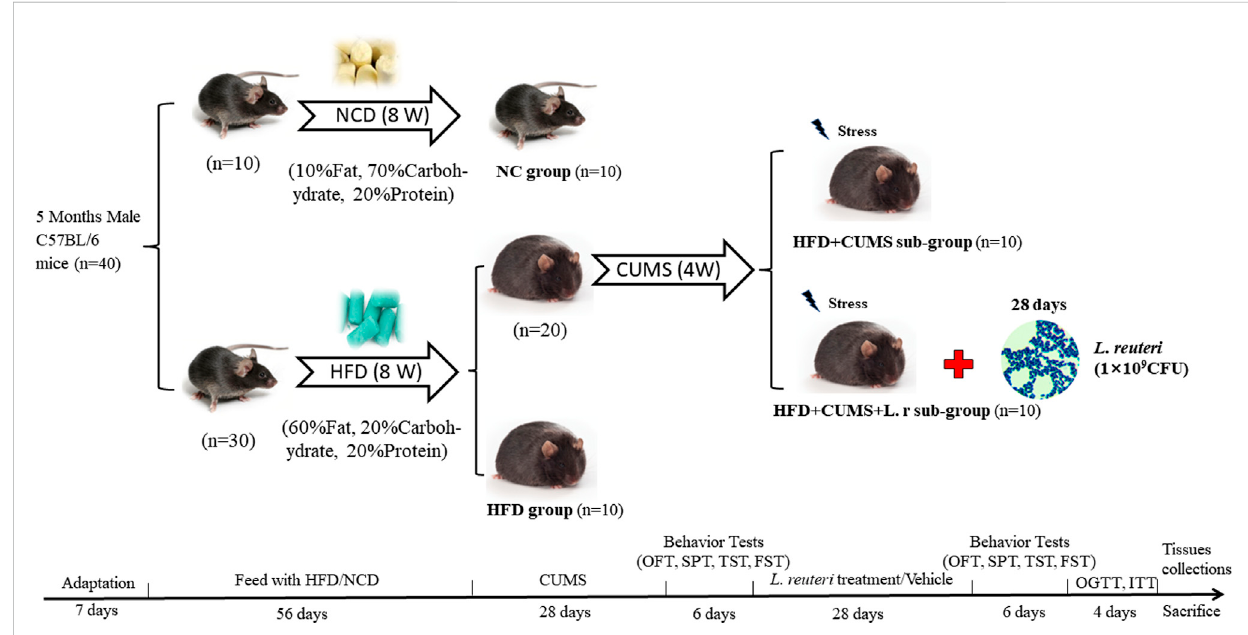
Scheme of the animal experimental design. All mice were adapted for 1 week before the experiments were conducted. Then mice were randomly divided into two groups (NC group, fed a normal diet, n = 10; HFD group, fed a high-fat diet, n = 30). After 8 weeks of feeding, the HFD group was randomlydividedintothreesubgroups.(HFDgroup, n =10;HFD+CUMSgroup, n =10;HFD+CUMS+L.rgroup, n =10).TheHFD+CUMSandtheHFD +CUMS+L.rsub-groupsunderwent4-weekchronicunpredictablemildstress(CUMS)interventions.Followedby6 daysofbehaviortests(behavior testsintheorderofOFT,SPT,TSTandFST).Afterbehaviortests,theHFD+CUMS+L.rgroupunderwenta4-weekgavageof0.5 mL Lactobacillusreuteri (2×10 9 CFU/mL)andtheothergroupsunderwentanequaldoseofPBS.Thenbehaviortestswereperformedfor6 daysaftertheendofthegavage.Later mice were performed the OGTT and ITT. Finally, mice were sacri fi ced and the tissue samples were collected.